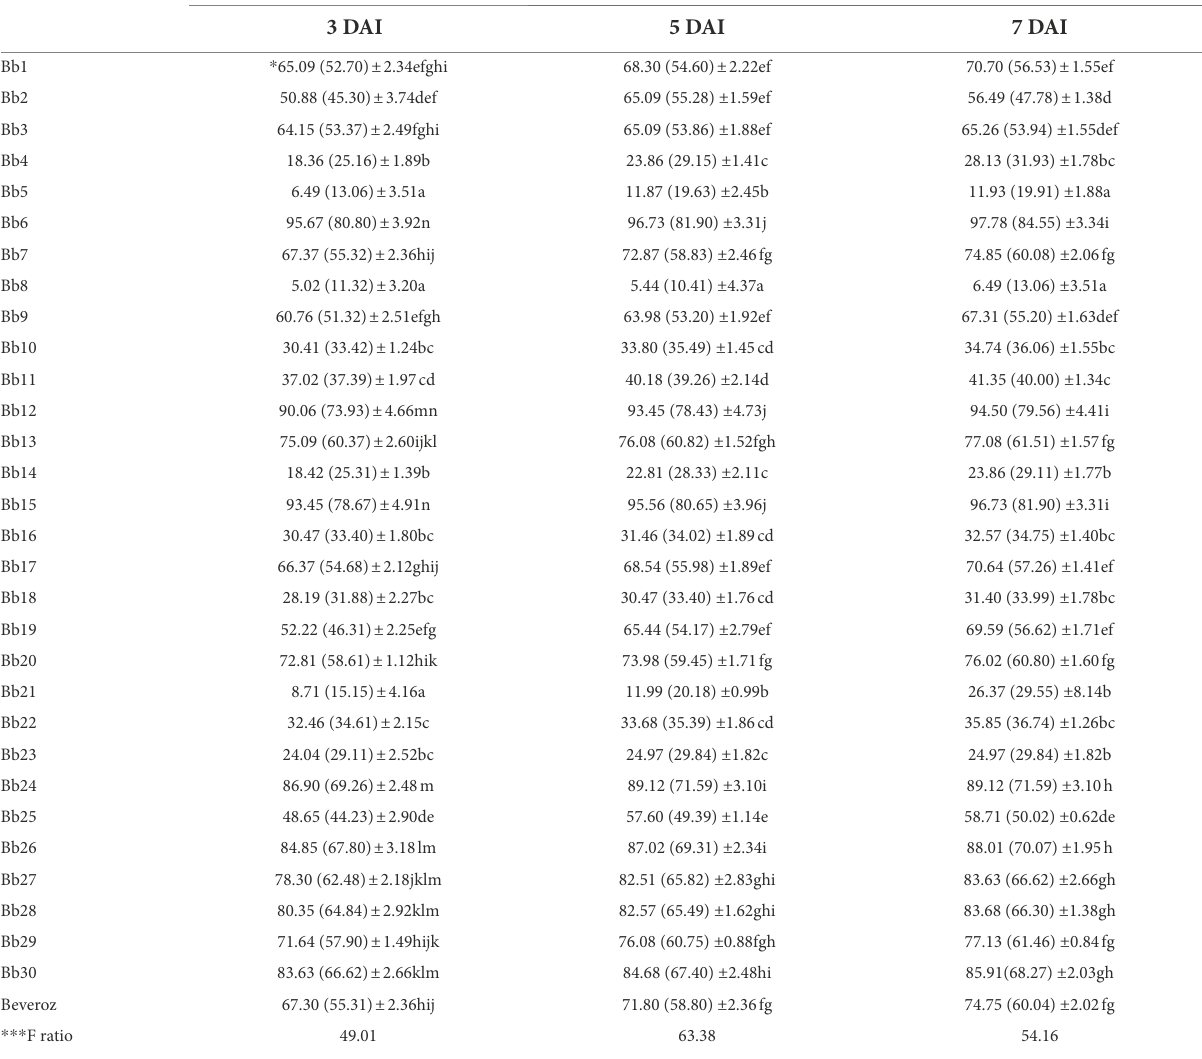
TABLE 2 Corrected mortality of T. truncatus infected with B. bassiana isolates.